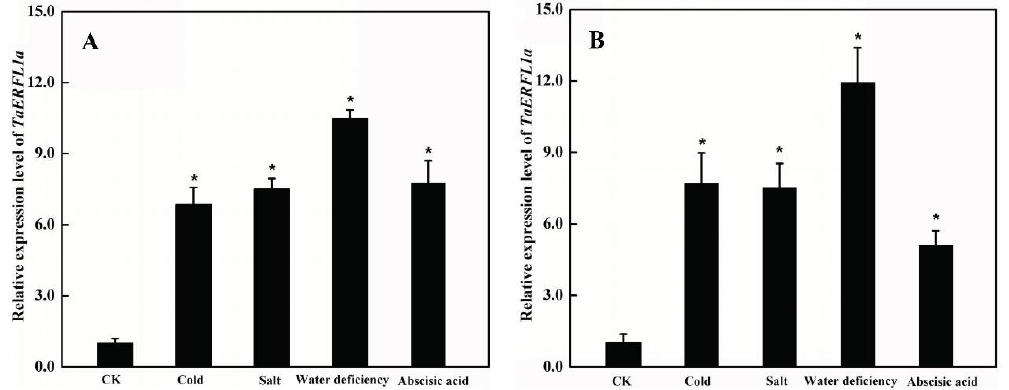
Figure 2. Transcript levels of TaERFL1a in leaves of wheat plants suffering from cold (4 °C), salt (250 mM NaCl), water deficiency (20% PEG6000), and abscisic acid (0.1 mM) for 3 days. Transcript levels are determined by qPCR using Actin ( A ) and GAPGH ( B ) genes as internal controls. Each value is mean ± standard deviation of three biological replicates. Asterisks indicate significant differences ( p < 0.05).